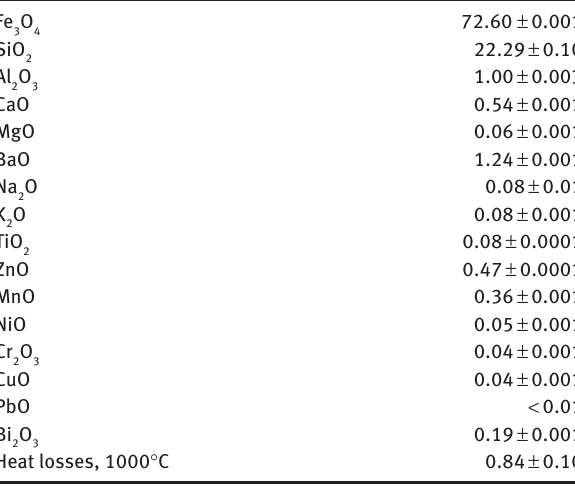
Table 3: Silicate analysis, AAS, and ICP-OES (in %) of the carbon black-magnetite hybrid filler ashes.